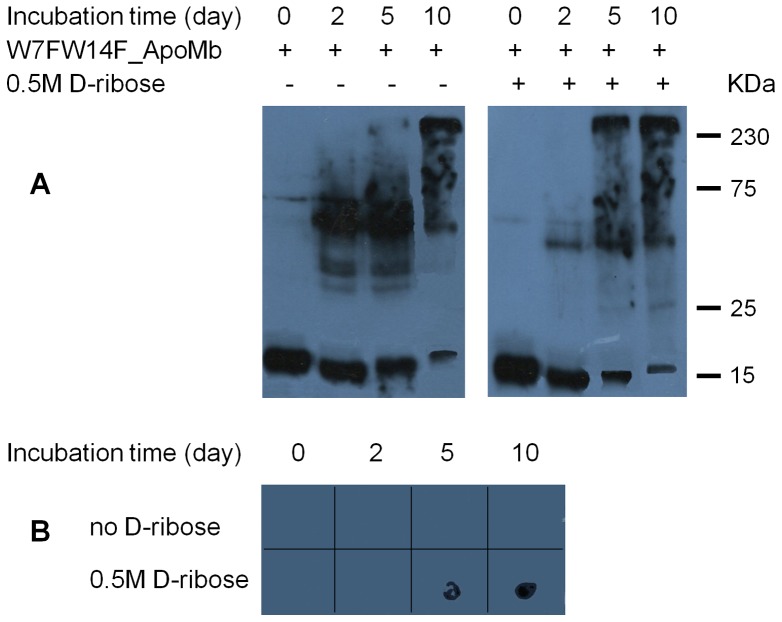
Western blot of ribosylated W7FW17F apomyoglobin.W7FW14F apomyoglobin was incubated in the absence and in the presence of 0.5M D-ribose and aliquots were taken at different time intervals. (A) Western blot analysis using an anti-myoglobin antibody. (B) Dot blot analysis using an anti AGE antibody. Experimental conditions are described in the Materials and Methods section.